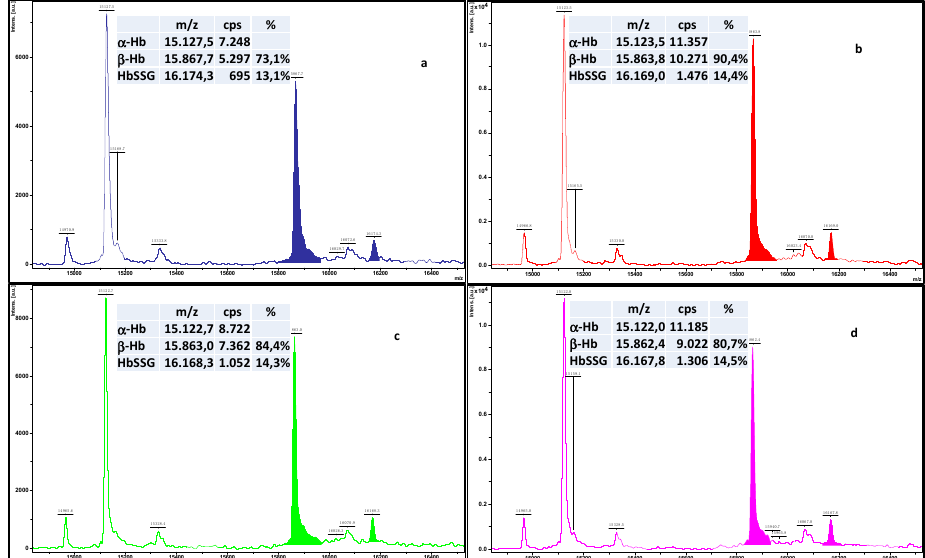
Figure 3. Superimposed traces of four depositions ( a – d ) from the same hemolysate-matrix mixture, measured with the automated acquisition method (50 shots summed over the sample spot area). Colour-highlighted areas correspond to the integration by the FlexAnalysis™ software, achieved under the best operating conditions and with optimized post-acquisition parameters. The boxes summarize the main measured peak areas and the relevant derived calculations.